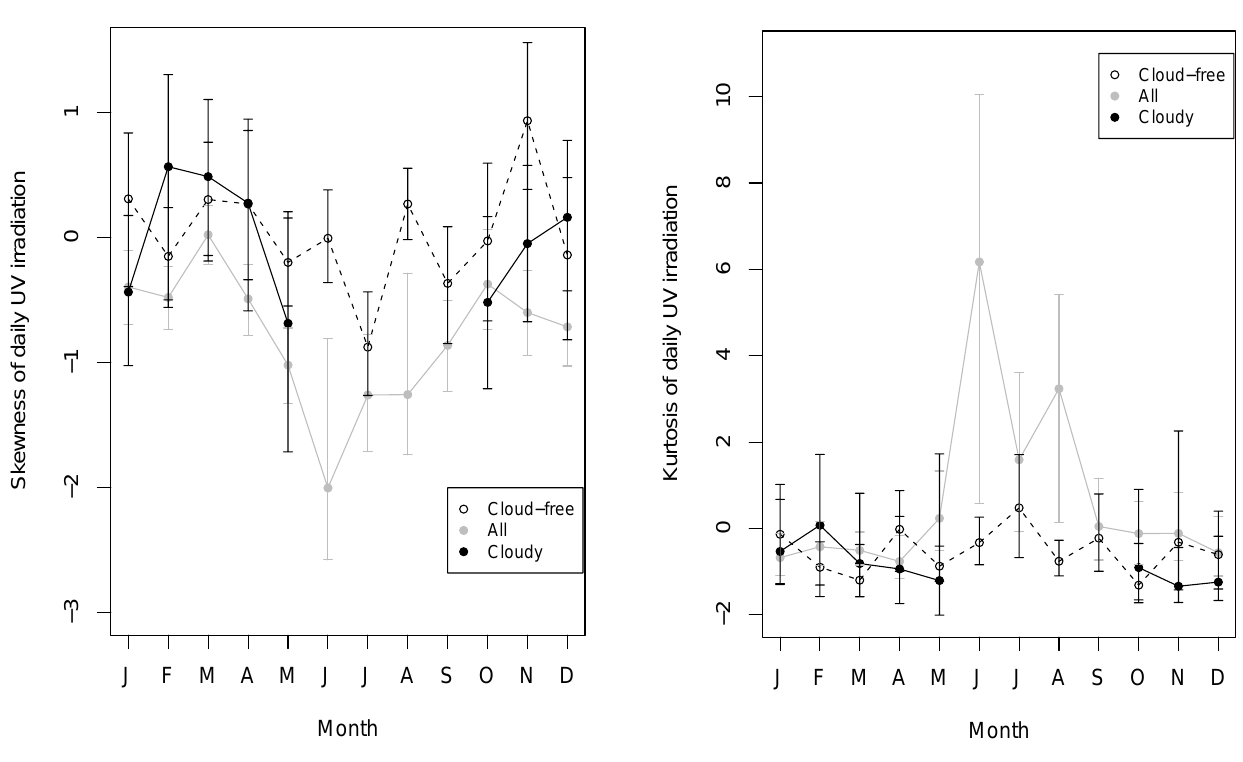
Fig. 8. Annual evolution of the kurtosis of daily ultraviolet erythemal irradiation.